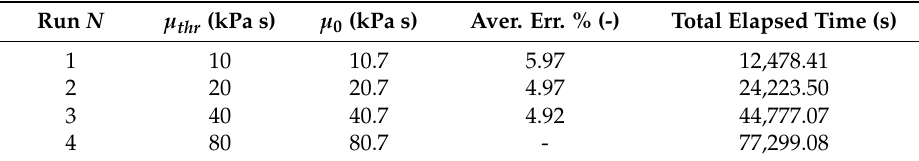
Table 1. Summary of the runs performed for numerical convergence of results with respect to threshold viscosity. Run N µ thr (kPa s) µ 0 (kPa s) Aver. Err. % (-) Total Elapsed Time